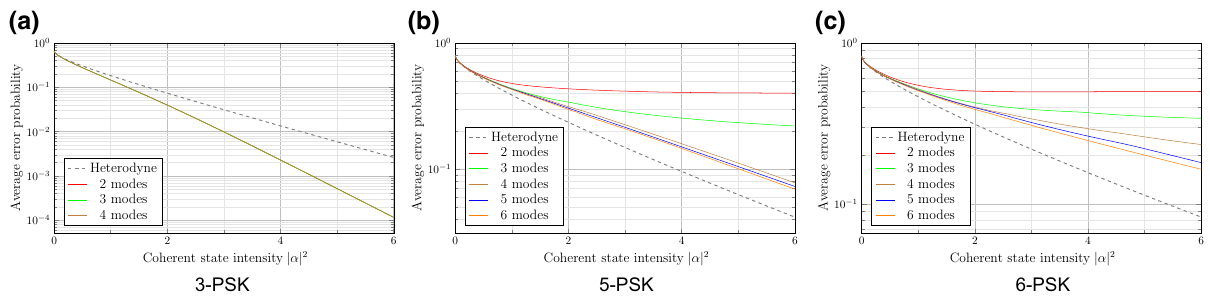
FIG. 10. Average error rate for M -PSK signal discrimination with M = { 3, 5, 6 } and varying numbers of ancillary modes. We apply our nonadaptive linear optical optimization scheme and extend the discrimination beyond the regime of weak signals (where | α | 2 >